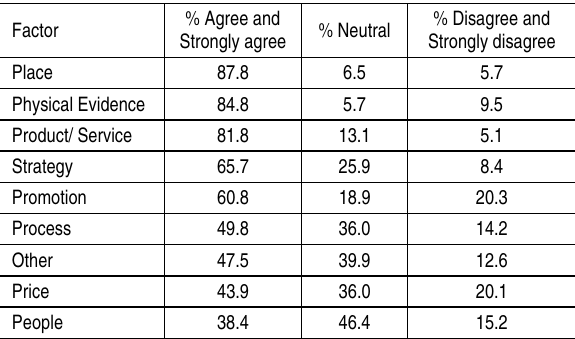
Table 4. Summary of factor